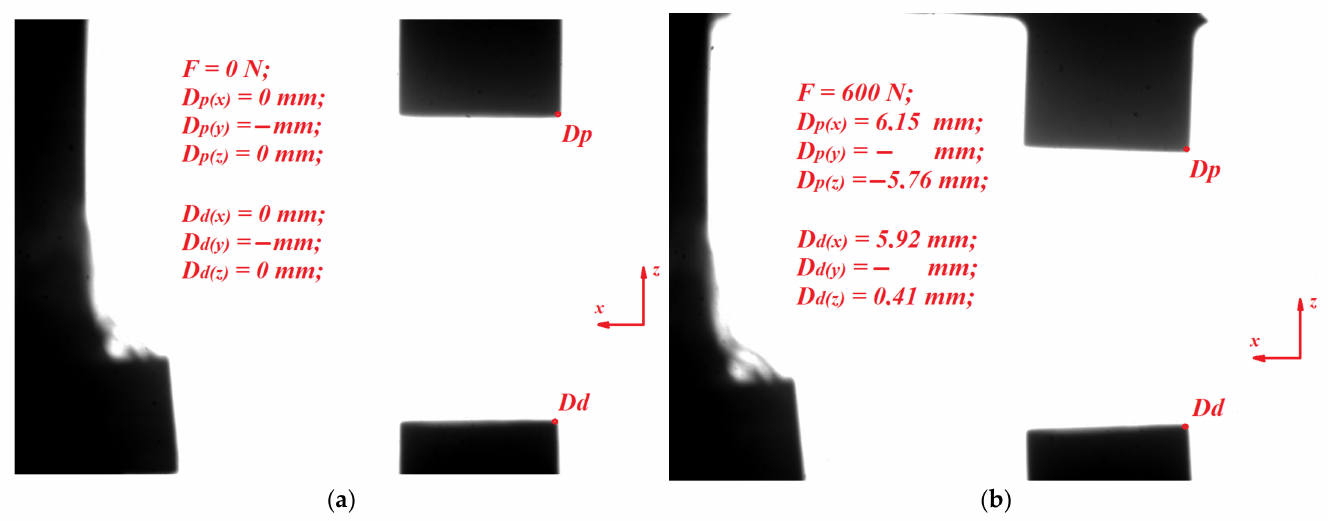
Figure 12. Displacement at the site of fracture; ( a ) F = 0 N, ( b ) F = 600 N. With usage of the displacement values for the bone segment models and Equation (3), relative displacements ( r (D)x , r (D)y i r (D)z ) of the analyzed points at the proximal and distal zones are